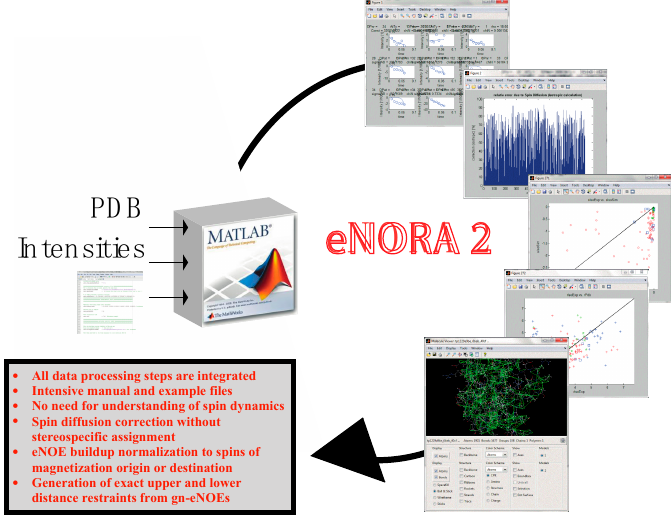
Figure 6. The eNORA2 program for eNOE analysis; eNORA2 significantly speeds up and automates the process of eNOE extraction and data processing, decreasing the time required from several months to ca. 2 weeks. See reference [43] for more information regarding this program.